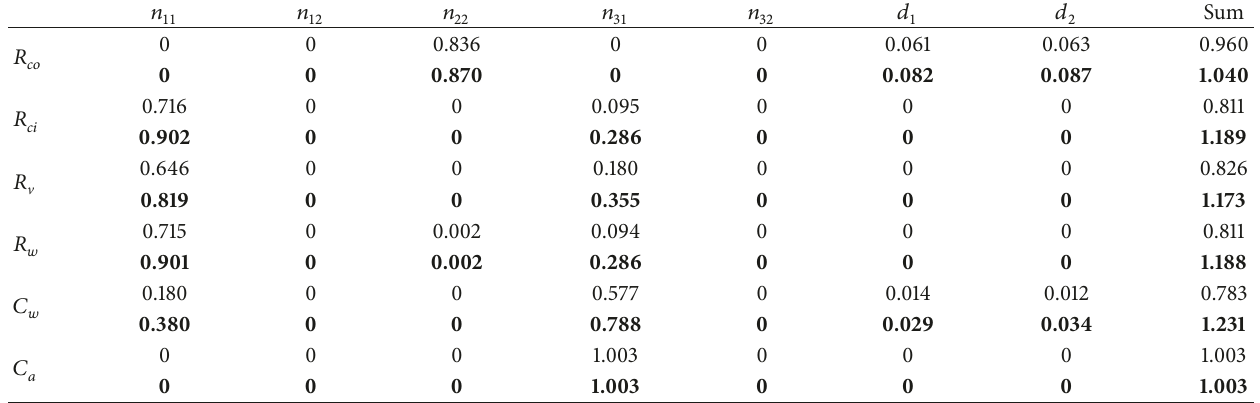
Table 12: First-order and total sensitivity indices, ARX to RC